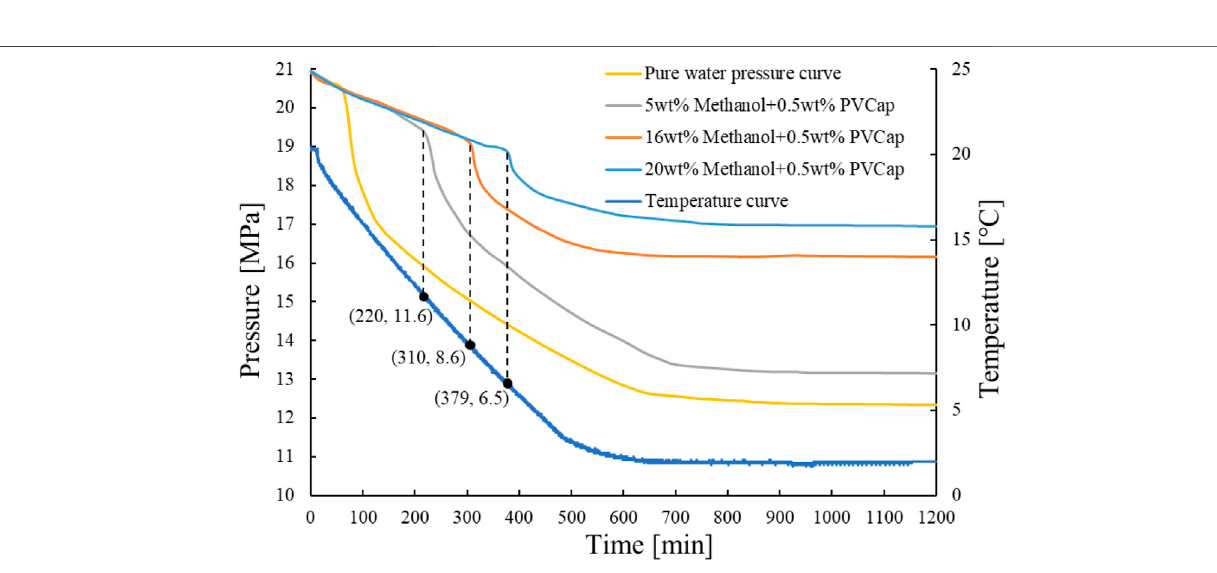
FIGURE 7 | Temperature and pressure pro fi le in different concentrations of methanol and